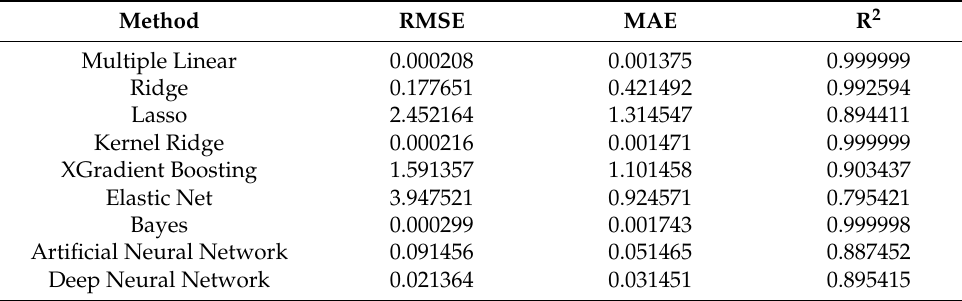
Table 6. Error metric values for fuel consumption prediction (primary findings).